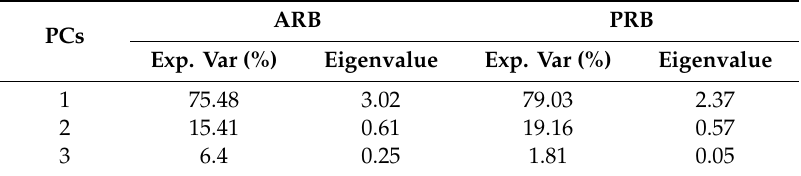
Figure 2. Time series observed streamflow vs. estimated streamflow of Quibdó and Pusmeo gauge stations. Table 3. Explained variance and eigenvalue of the first three principal components at each basin.